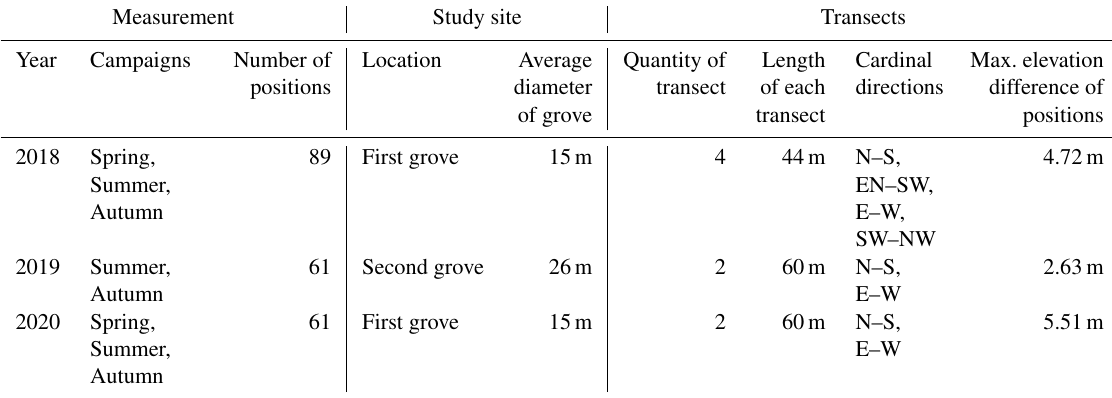
Table 1. Measurement campaigns during the study. Measurement Study site Transects Year Campaigns Number of Location Average Quantity of Length Cardinal Max. elevation positions diameter transect of each directions difference of of grove transect